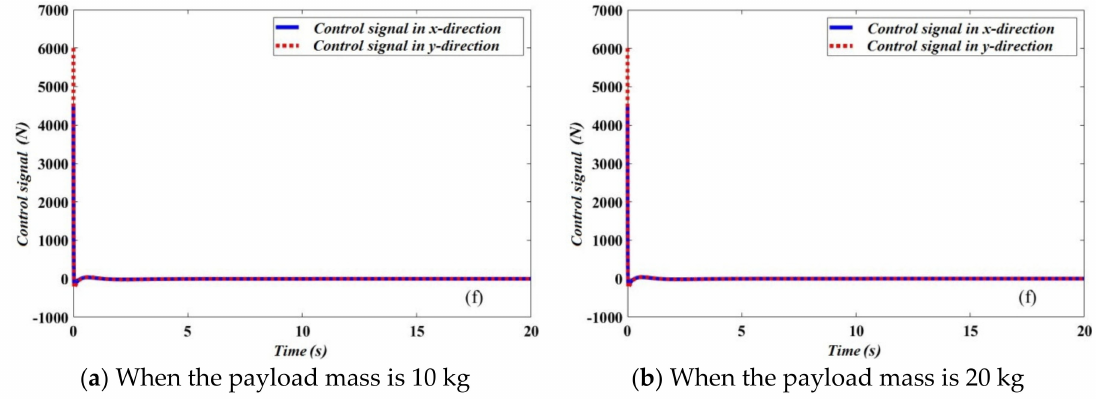
Figure 4. The control force